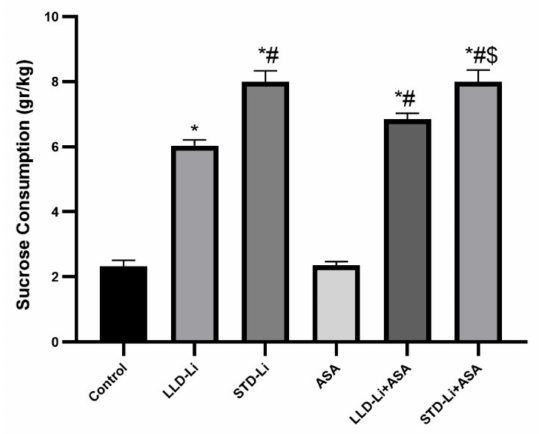
Figure 11. Rats were fed regular food (control) or lithium-containing food [LLD-Li or STD-Li]. On day 21 of the treatment rats were offered two bottles, one containing sucrose solution and one—regular drinking water as described in Materials and Methods. Sucrose consumption in each cage was calculated according to the body weight of the rats (three) in the cage. Results are the means ± SEM of a single representative experiment out of two demonstrating a similar pattern with 9–12 rats per group in the depicted experiment. Two-way ANOVA: ASA effect, F 1,48 = 1.711, p = 0.1738; Li effect, F 2,48 = 278.7, p < 0.0001; aspirin x Li interaction, F 2,48 = 1.711, p = 0.1915. Post hoc Fisher’s LSD test: Control vs. LLD-Li, p < 0.0001; Control vs. STD-Li, p < 0.0001; Control vs. ASA, p = 0.9362; Control vs. LLD-Li + ASA, p < 0.0001; Control vs. STD-Li + ASA, p < 0.0001; LLD-Li vs. STD-Li; LLD-Li vs. LLD-Li + ASA, p = 0.0254; STD-Li vs. STD-Li + ASA, p = 0.997; LLD-Li + ASA vs. STD-Li +ASA, p = 0.0019. Asterisks and symbols denote the following: *— p < 0.05 vs.